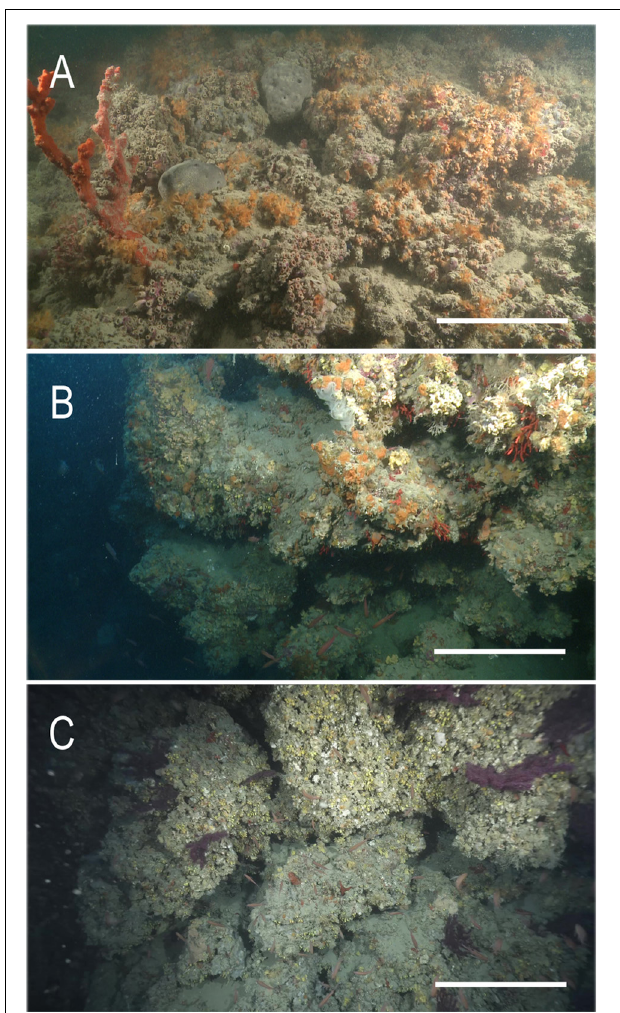
FIGURE 2 | The mesophotic biocostructions of the Apulian coast (Italy): (A) Monopoli, 43 m depth; (B) Otranto, 52 m depth, (C) Santa Maria di Leuca, 60 m depth. Scale bars: (A) 10 cm; (B) 30 cm; (C) 60